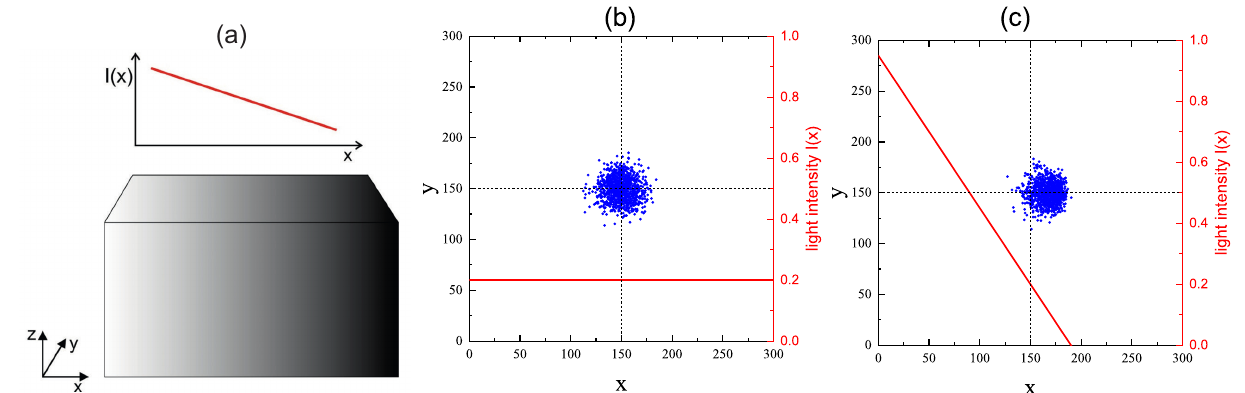
Figure 13. ( a ) Model of the system and illumination pattern. Projection of CM of 10 3 chains onto x - y plane at the end of the simulation for I 0 = 0.2 and ∇ I = 0 ( b ) and ∇ I = 0.005 ( c ). T = 0.25. [163].